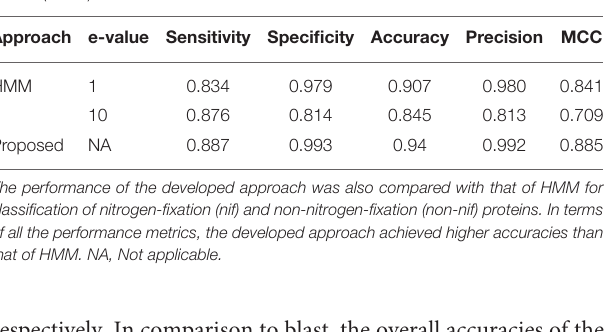
TABLE 2 | Performance metrics of the proposed approach and blast algorithms. TABLE 3 | Performance metrics of the proposed approach and hidden Markov model